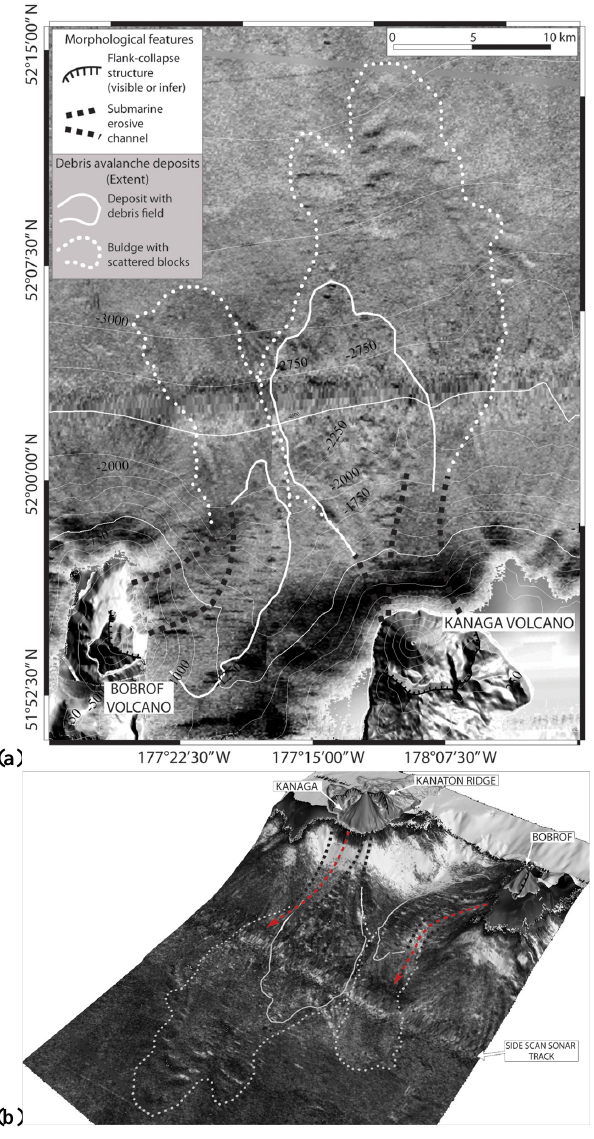
Fig. 8. (a) Plan view: topography, bathymetry and Gloria side-scan data of northern slope of Bobrof and Kanaga islands. The image displays the DA from both the islands; the two active canyons affect the deposits are also showed. Black is high backscatter, white is low backscatter and contour interval is 250m. (b) 3-D view. Black is low backscatter and white is high backscatter.